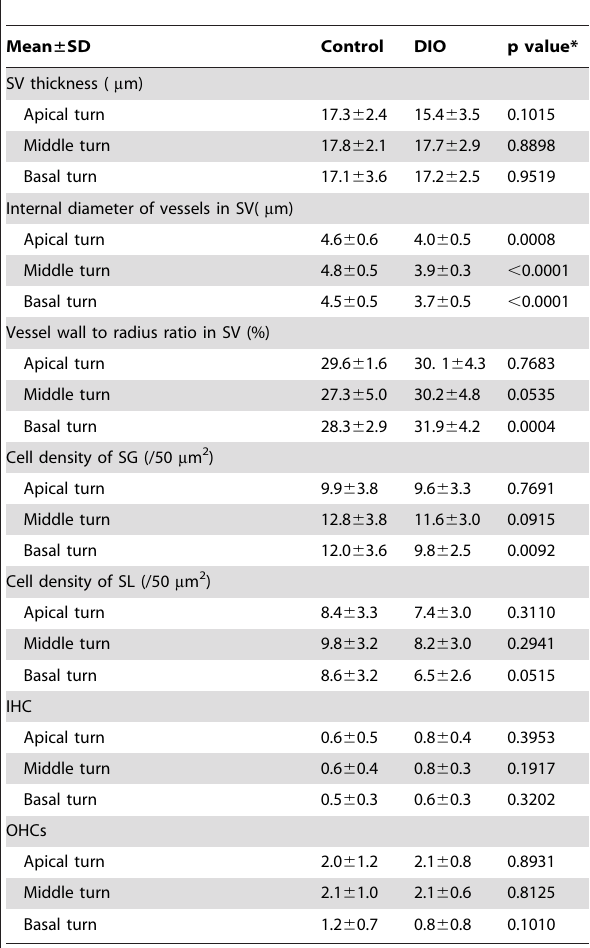
Table 3. Observations of cochlear sections by H&E stain in both groups at the end of this